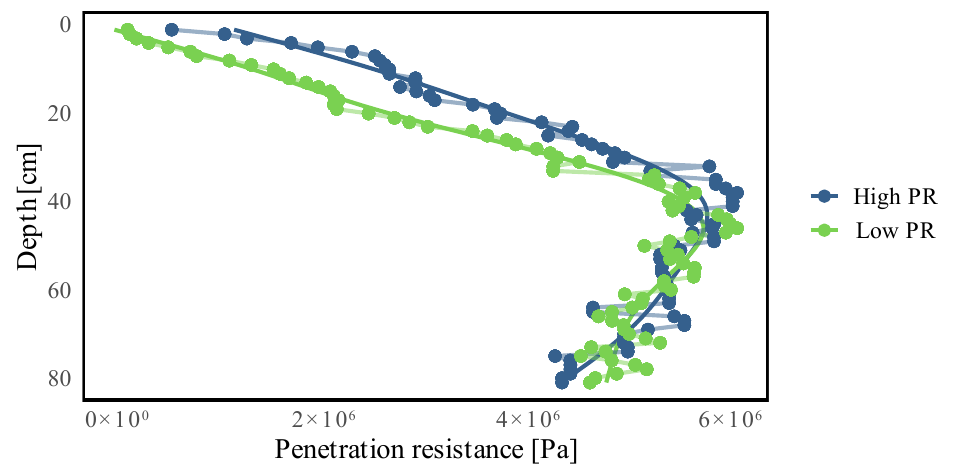
Figure 2. Average values of high (blue) and low (green) PR along the soil profile, defined in the 0–5 cm soil layer.